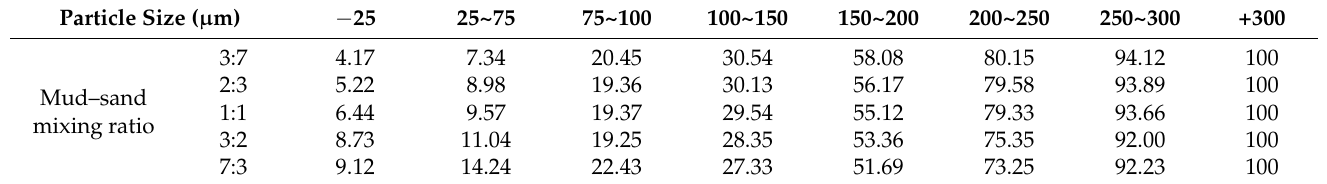
Table 6. Effect of the mud – sand mixing ratio on cumulative particle size content. Particle Size ( μm )